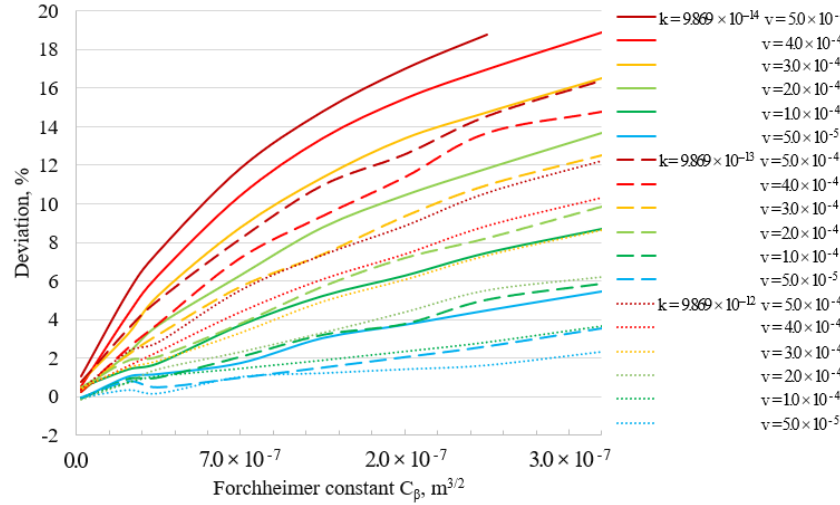
Figure 10. Distance deviation of waterflood front with various parameters.